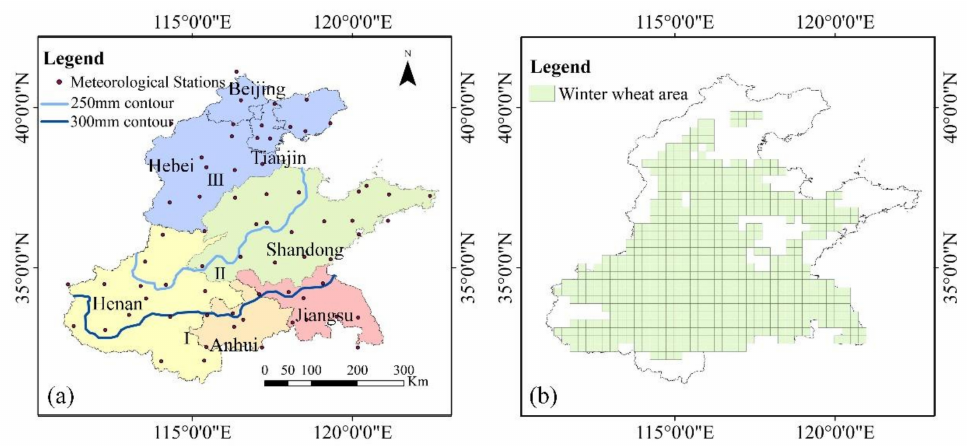
Figure 1. Study area: the location of the meteorological stations ( a ) and crop regions of winter wheat ( b ) in the North China